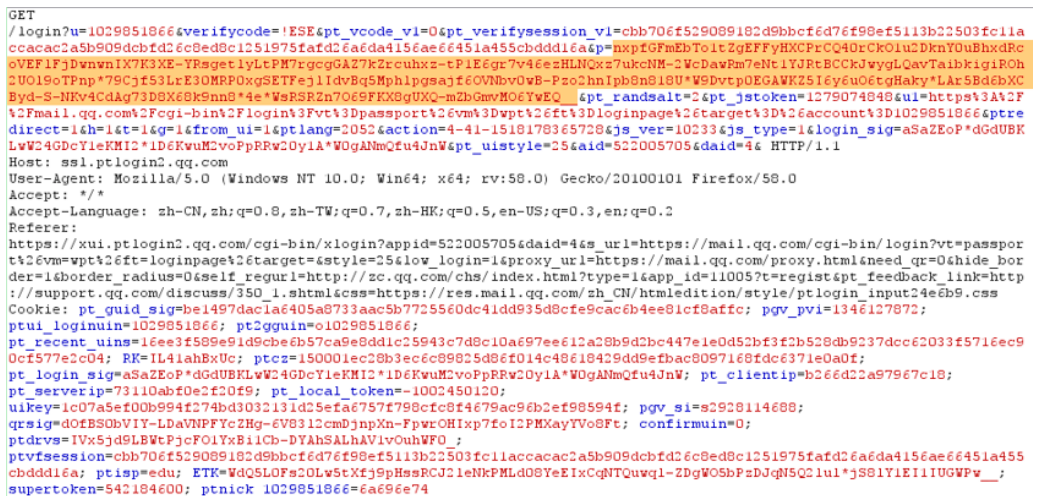
Figure 27. The reconstructed output of the traced functions.